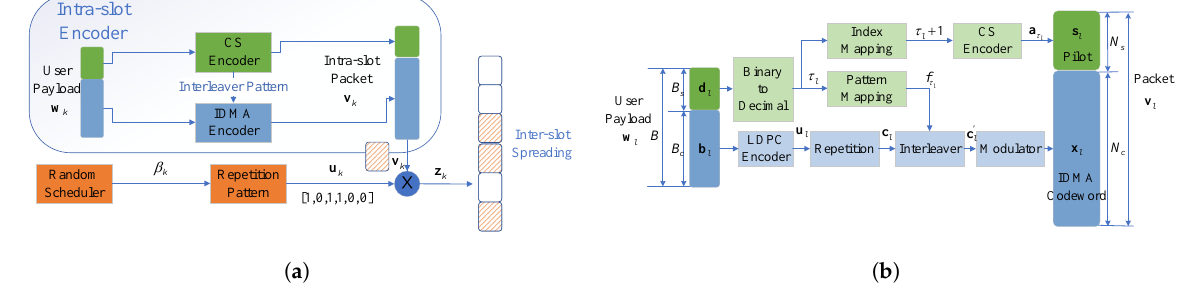
Figure 2. ( a ) The overall structure of the encoder. ( b ) The Intra-slot